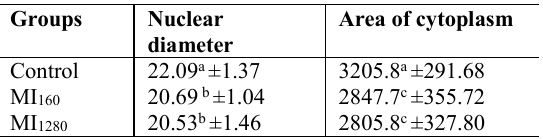
Table 4. Mean diameter (μm) and cytoplasmic area (µm 2 ) of BMSCs after 36 hours of treatment with myo-inositol.